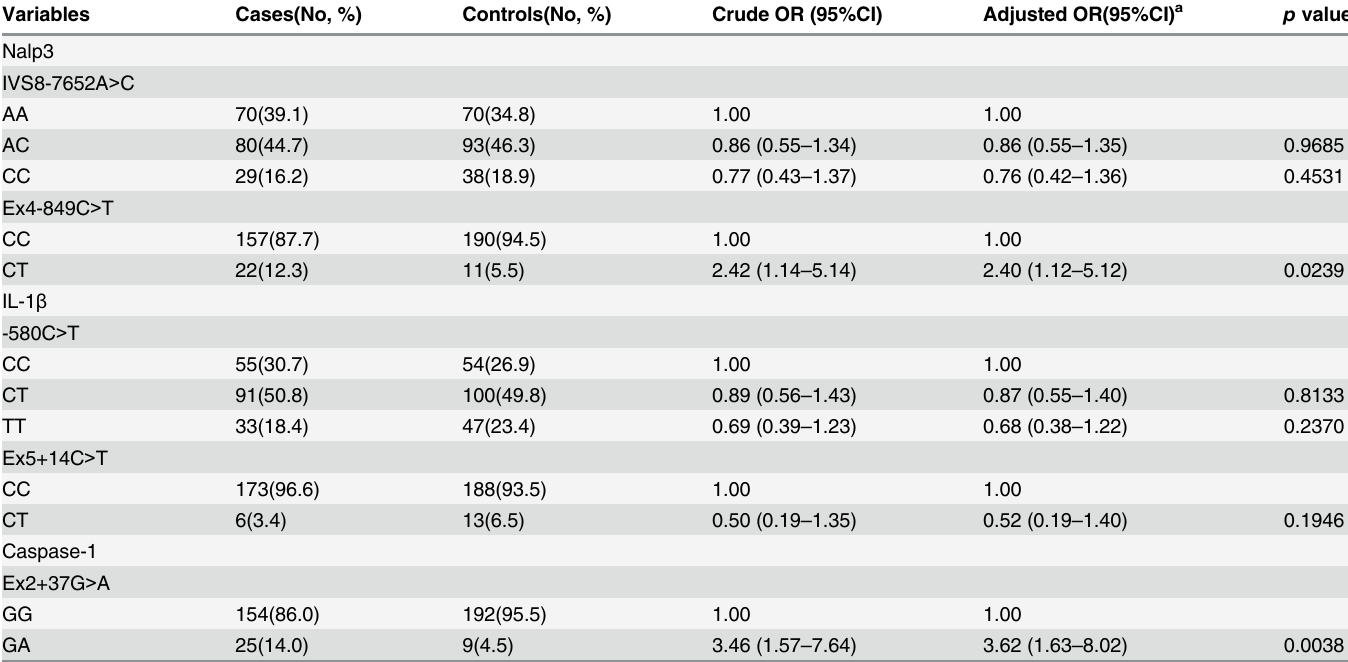
number of years of dust exposure of silicosis patients was shorter than that of the controls non-dust exposure jobs once silicosis was diagnosed. Table 3 lists the genotype frequencies among silicosis cases and controls. No significant dif- ferences were found in the genotype frequencies of the IVS8-7652A > C polymorphism in Nalp3 between patients with silicosis and subjects in the control group. The distribution of the Ex4-849C > T polymorphism in Nalp3 was significantly different between the cases and con- trols (p = 0.0185). After adjusting for age, smoking status, and CDE, subjects with the T allele Table 3. Genotype frequencies and associated risks of silicosis in case and control subjects.